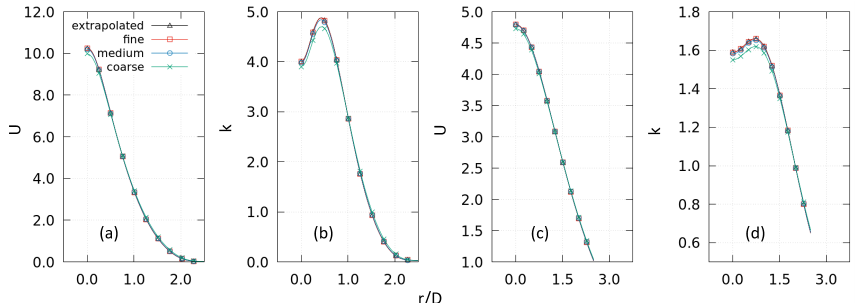
Figure 2. Solutions for fine, medium, and coarse grids and Richardson extrapolation at ( a , b ) 10D and ( c , d ) 20D normal